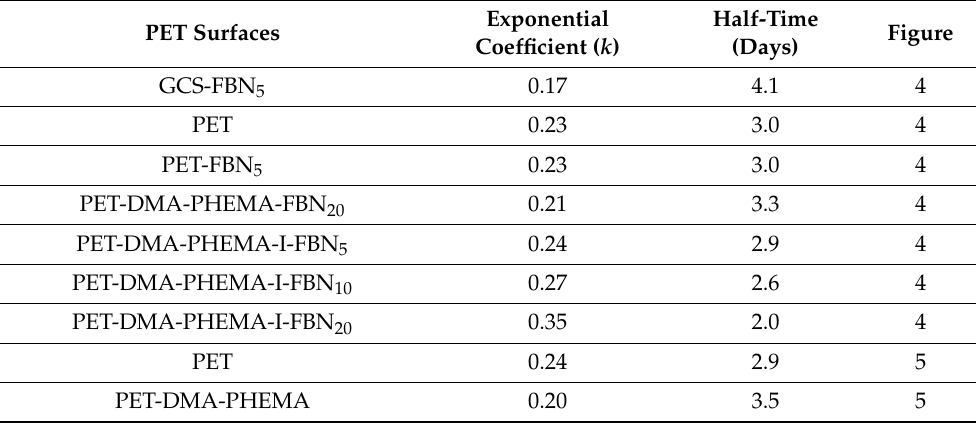
Table 2. Measurement of cell growth on glass and PET surfaces. Curves of cell growth were fitted to exponential curves, and the exponential coefficient k, which indicates the speed of growth (in A = A 0 e kt ) calculated. Another way to estimate cell growth is the doubling time (half-time) calculated (half-time = ln(2)/ k ) and shown in the right